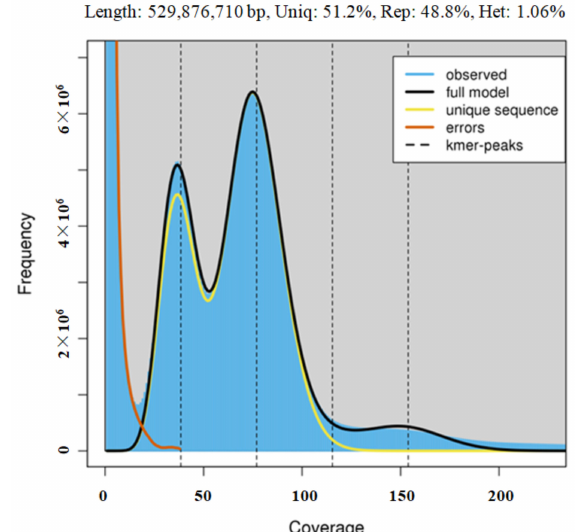
Figure 2. k-mer distribution as calculated by Genomescope. Blue bars represent the observed k-mer distribution; black line represents the modelled distribution without the k-mer errors (red line) and up to a maximum k-mer coverage specified in the model (yellow line). length, estimated genome length; uniq, unique portion of the genome (nonrepetitive elements); het, genome heterozygosity; rep, repetitive portion of the